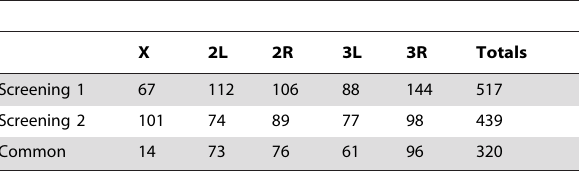
Table 1. Number of genes identified by the screening methods 1 and